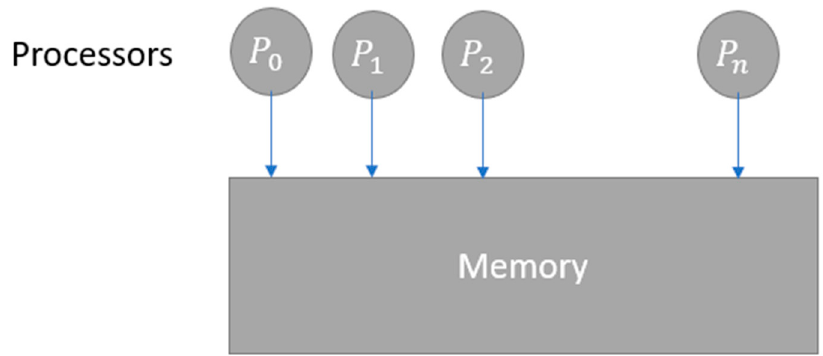
Figure 19. Shared memory architecture.